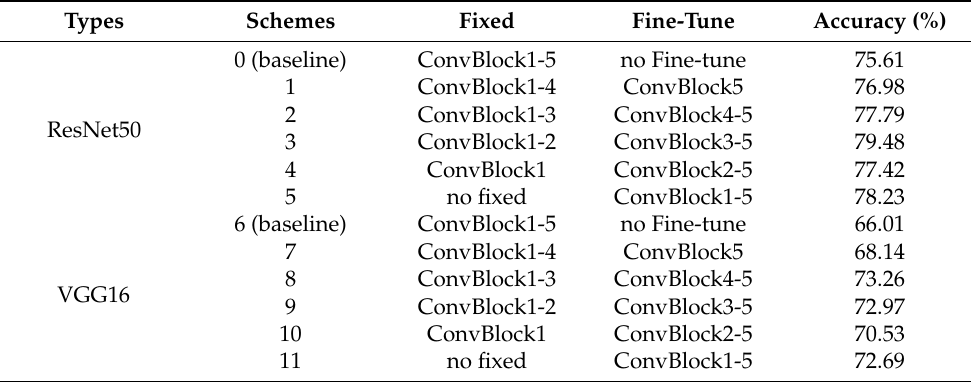
Table 10. The impact of different transfer learning strategies on test accuracy.